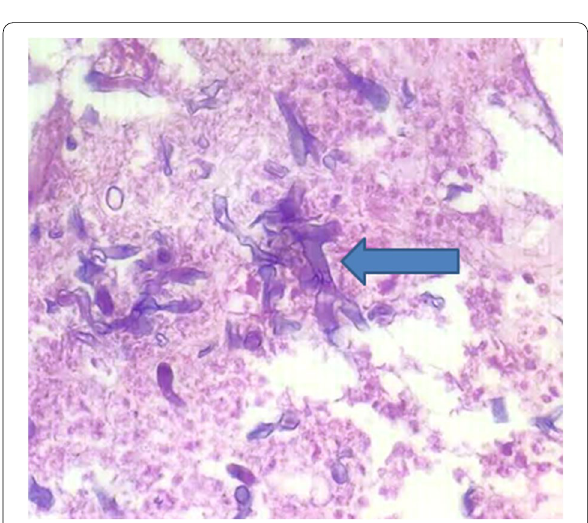
Fig. 3 HPE image showing broad, aseptate and obtuse angle branched fungal hyphae—suggestive of